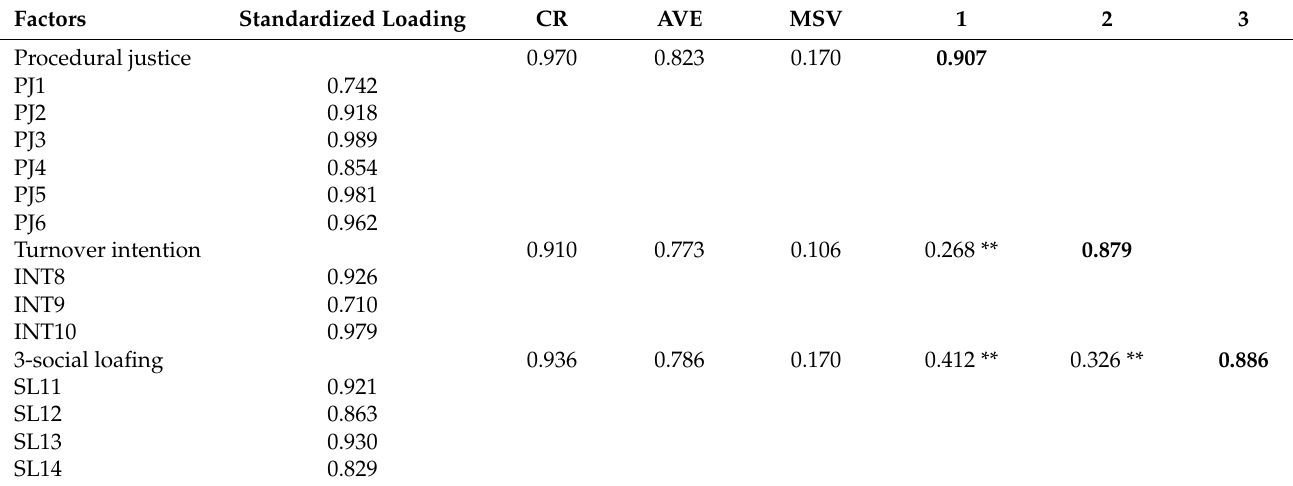
Table 2. Convergent and discriminant validities (developed by the authors).